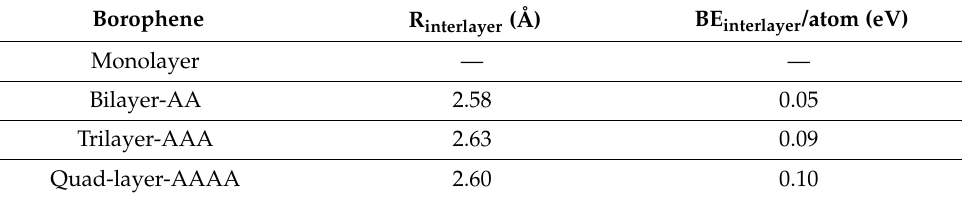
Table 1. Multilayer borophene: the interlayer distance (R interlayer ) and the interlayer binding energy (BE interlayer ) are calculated at the PBE + D2 level of theory. BE interlayer = E n − nE monolayer with n = 2, 3,